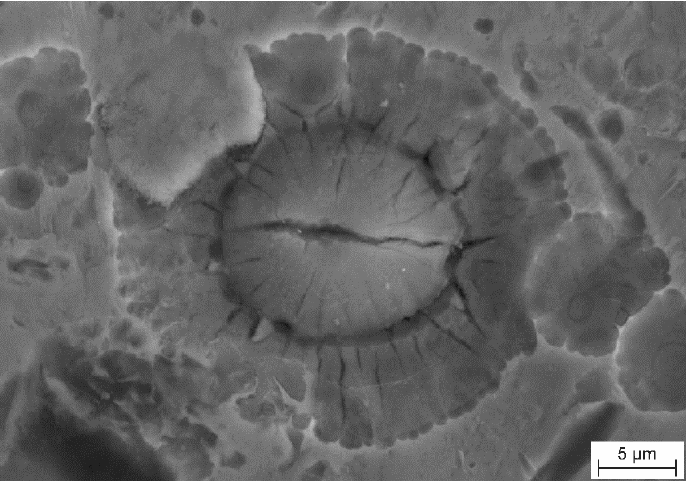
Figure 2. SEM image of a bulk glassy Zr 59 Ti 3 Cu 20 Al 10 Ni 8 alloy sample surface after shot-peening for 30 s and subsequent exposure to 6 M HCl for several